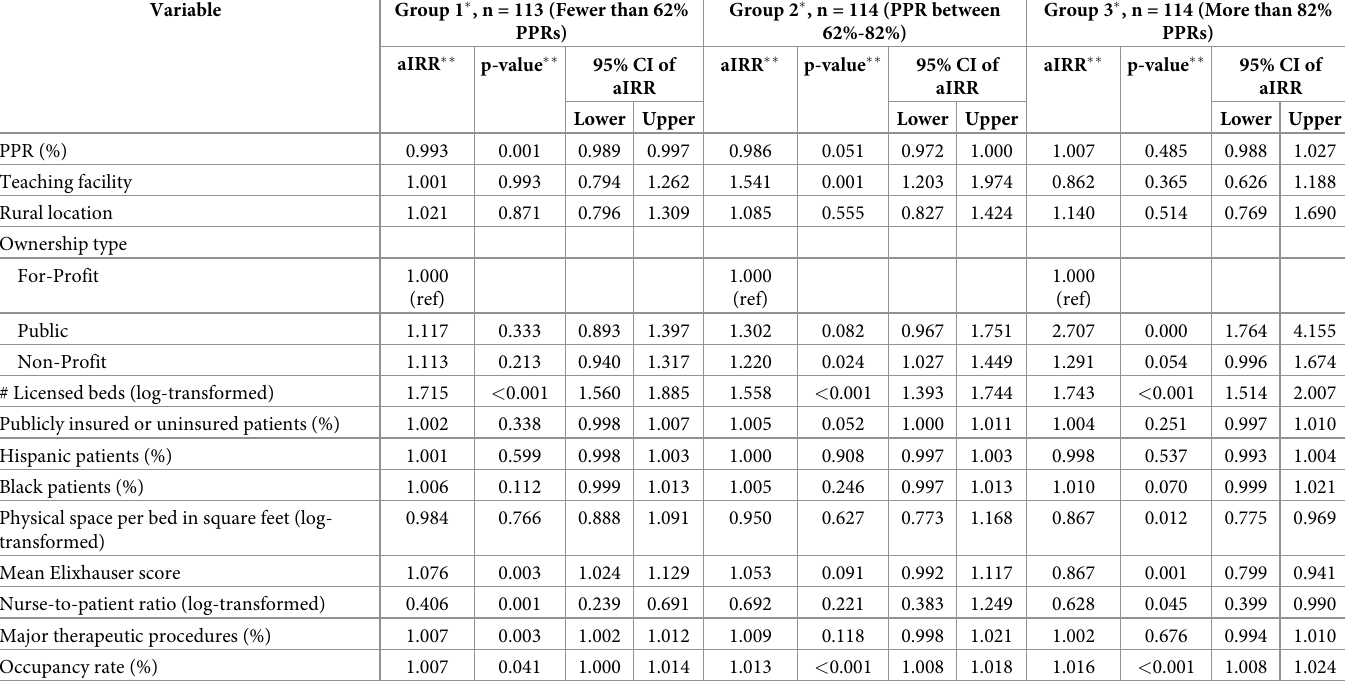
Table 4. Adjusted associations between the characteristics of 340 US hospitals and rates of methicillin-resistant Staphylococcus aureus (HA-MRSA) infection, by hospital group, based on discharges between September 2015 and August 2016.